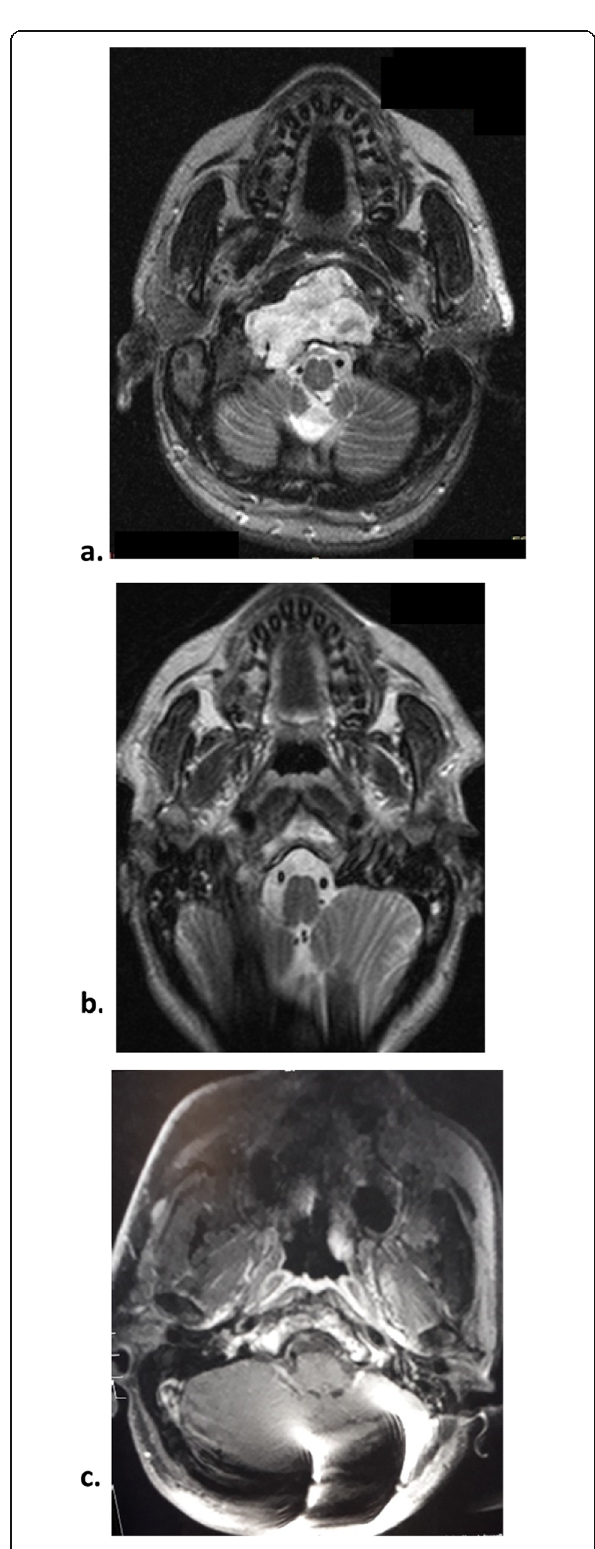
Fig. 2 Case 1. Preoperative ( a ) and postoperative ( b ) contrast MRI images. Last MRI scan ( c ) shows no disease